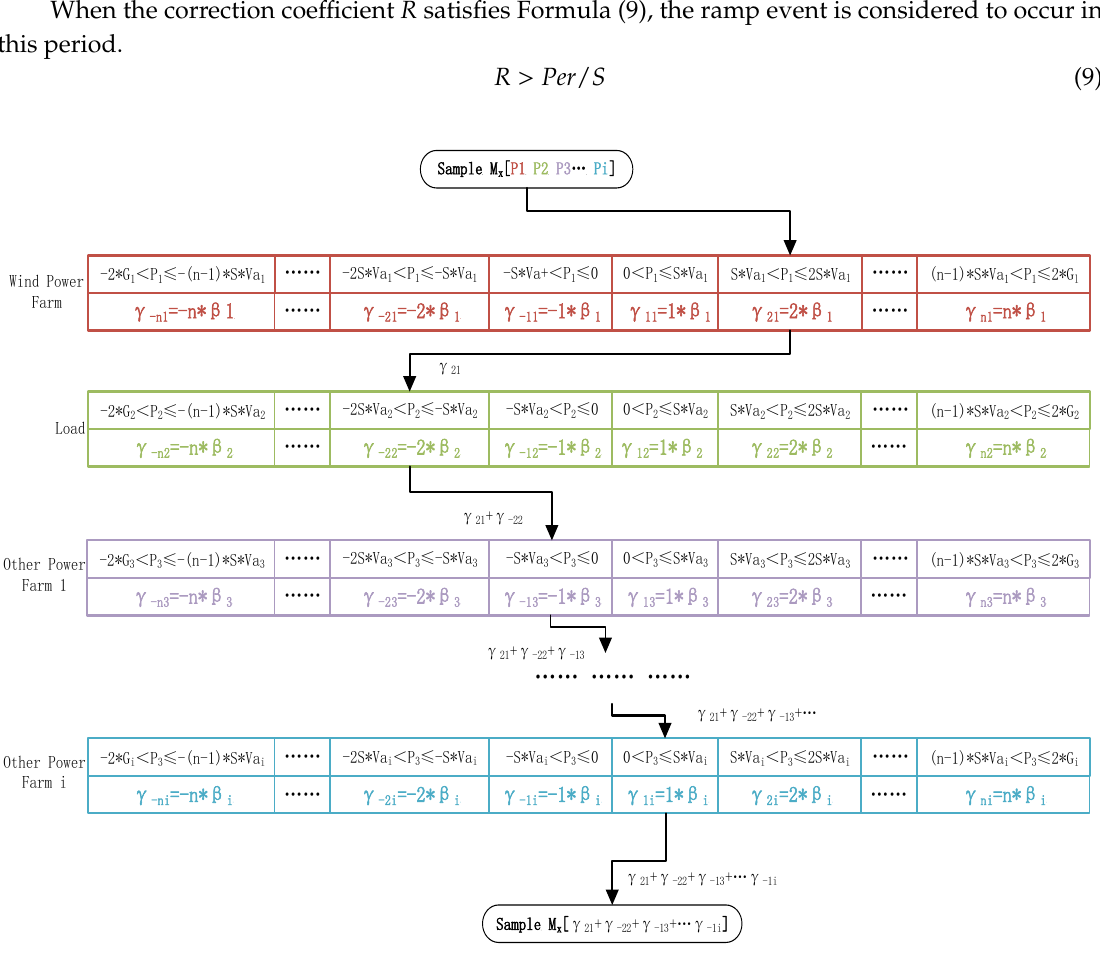
Figure 5. Channel self-selection multi-layer coefficient correction model (CSMCC).